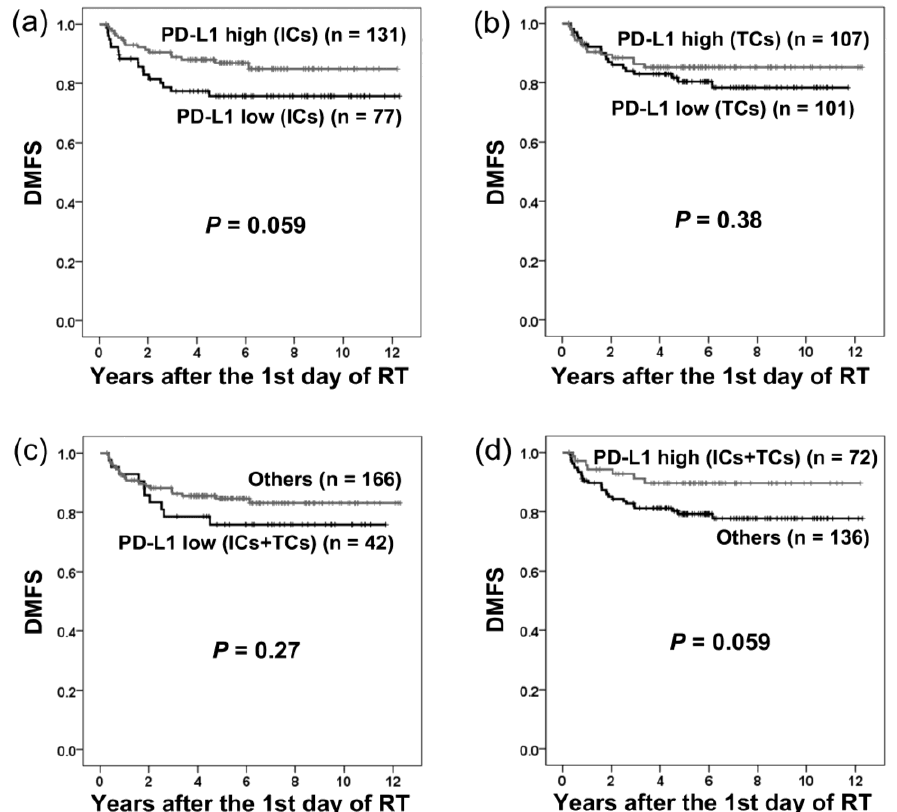
Figure 3. Distant metastasis-free survival (DMFS) in patients with different levels of PD-L1 expression on immune cells (ICs) and tumor cells (TCs). PD-L1 expression on ICs ( a ), TCs ( b ), or both ICs and TCs ( c , d ) had no significant influence on